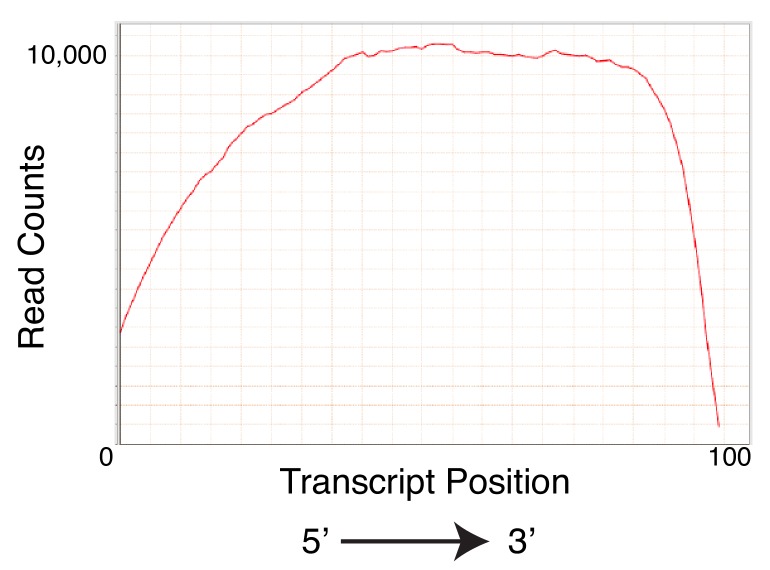
Uniform distribution of mapped reads from embryonic chick Probe-Seq for FGF8.A representative graph of gene body coverage of mapped reads from chick Probe-Seq.